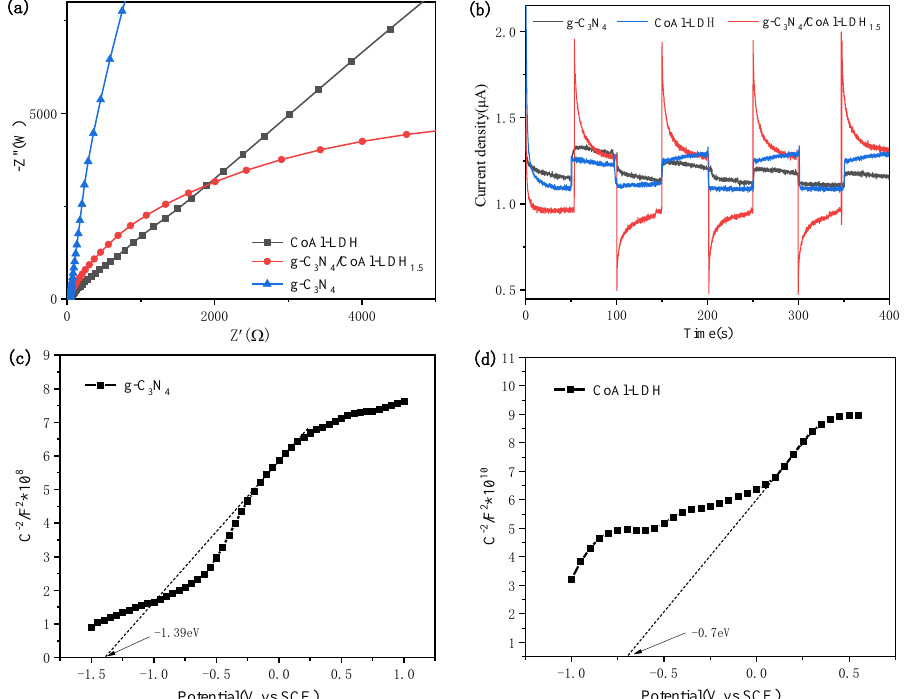
Figure 7. ( a ) EIS Nyquist plots; ( b ) I-T plots of g-C 3 N 4 , CoAl-LDH, and the g-C 3 N 4 /CoAl-LDH 1.5 nanocomposite. Mott – Schottky plots of: ( c ) g-C 3 N 4 ; ( d ) CoAl-LDH.